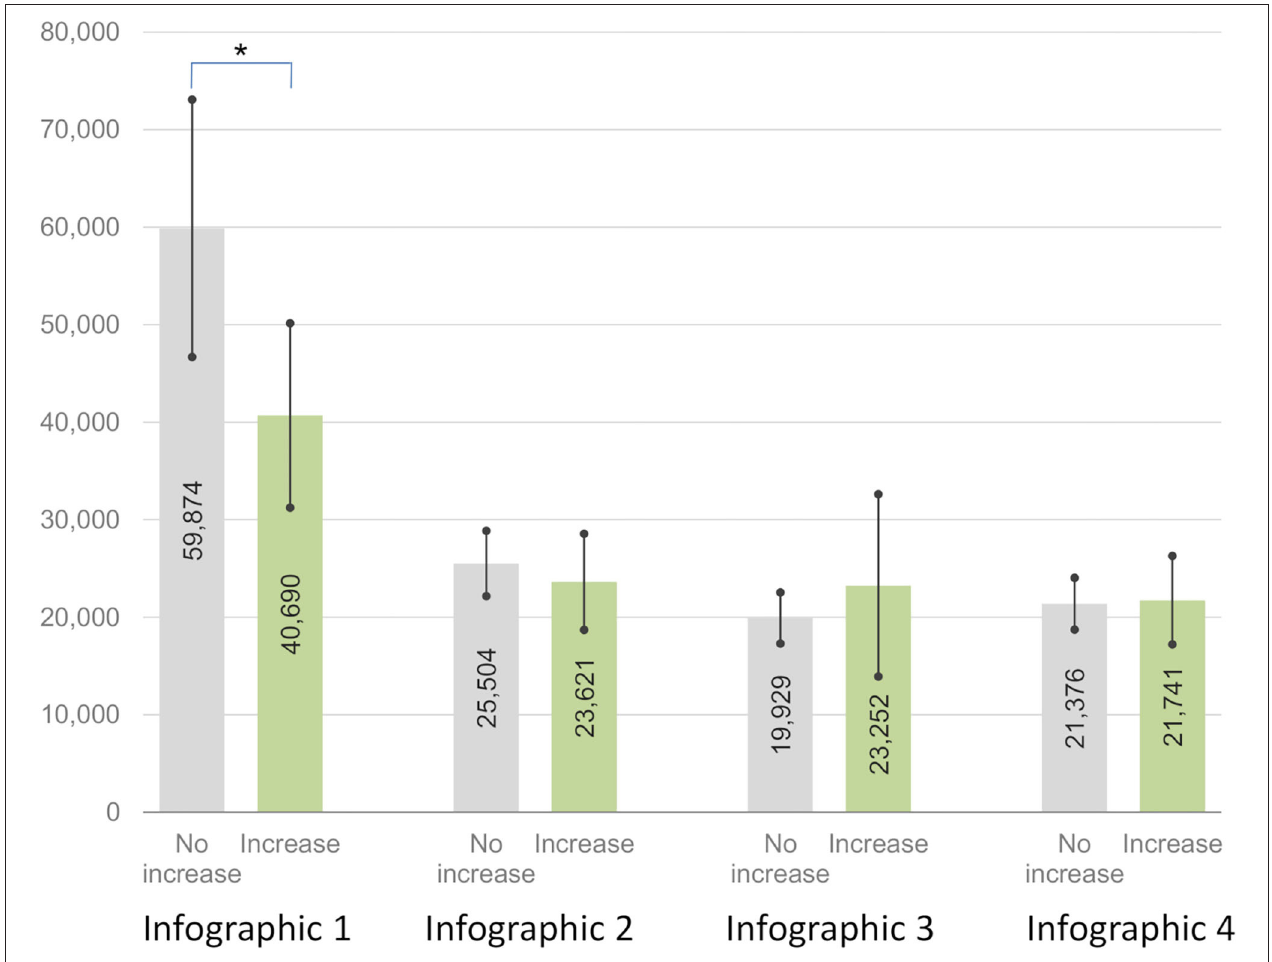
FIGURE 4 | Dwell time of visual attention to infographics 1–4 for groups with no increase and increase in debt literacy as an effect of debt education ab . a Mean dwell time in milliseconds. Significance: * p < 0.05. b Error bars represents 95.0% Lower and Upper CL for